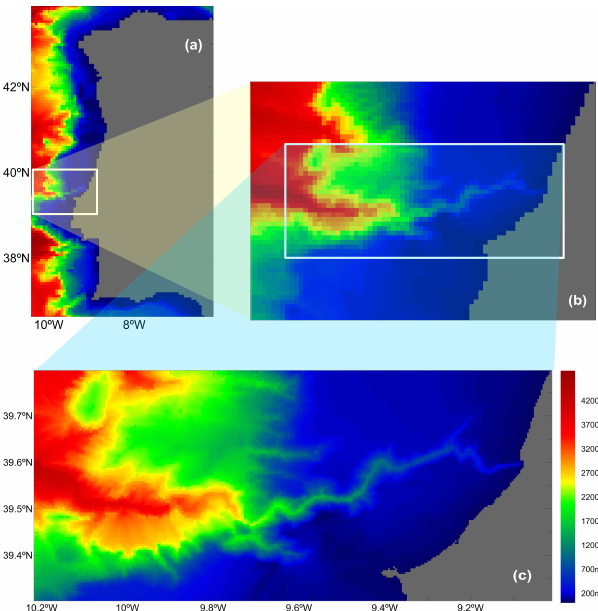
Fig. 1. Nazar´e canyon location at the western Iberia margin. The nested domains: (a) first level: MOHID-PCOMS; (b) second level: Figueira da Foz–Peniche; (c) third level: Nazar´e canyon.